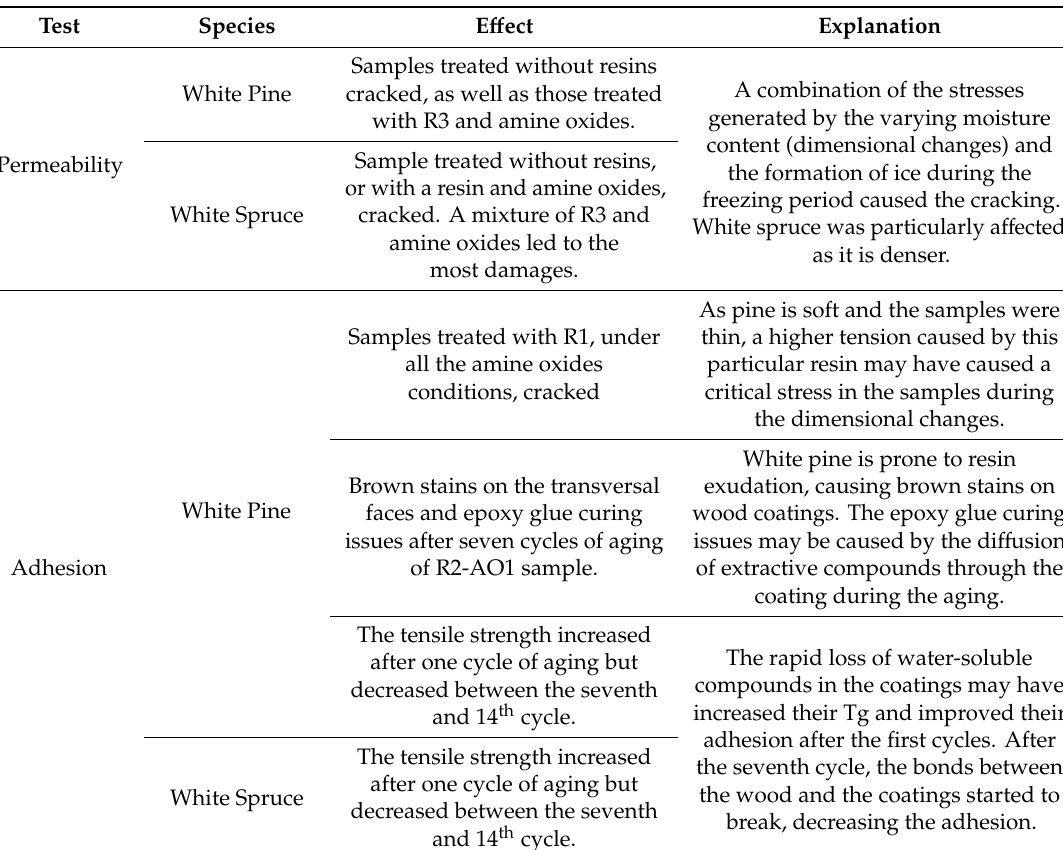
Table 10. E ff ects of artificial aging on the adhesion and permeability